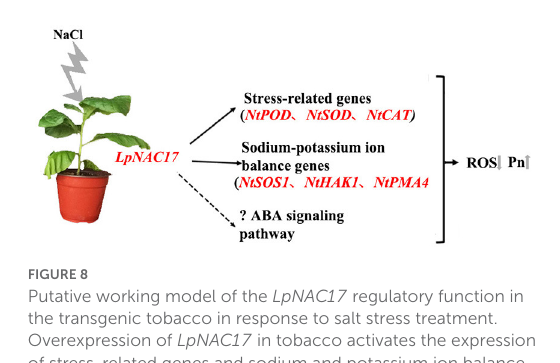
FIGURE8 Putative working model of the LpNAC17 regulatory function in the transgenic tobacco in response to salt stress treatment. Overexpression of LpNAC17 in tobacco activates the expression of stress-related genes and sodium and potassium ion balance factors, and possibly the ABA signaling pathway, leading to lower accumulation of reactive oxygen species (ROS) and higher Pn under salt stress and thus improved salt